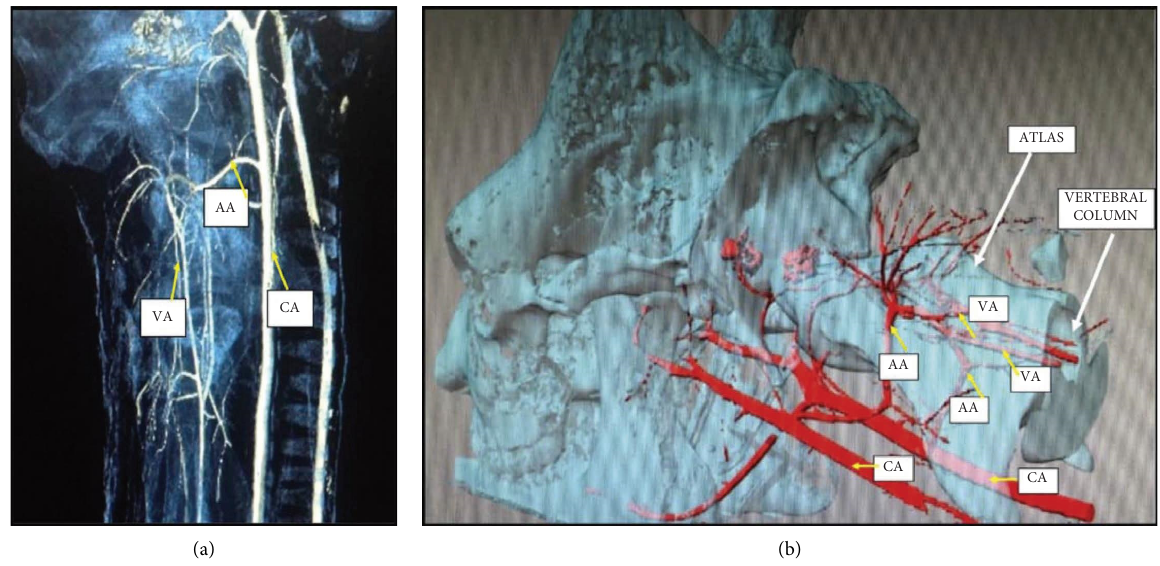
Figure 3: (a) Computerised tomography image illustrating the common carotid artery (CA), anastomotic artery (AA), and the vertebral artery (VA). (b) An illustration of the common carotid artery (CA), anastomotic artery (AA), and vertebral artery and the course of the vertebral arteries within the vertebral column through the atlas where they connect to the anastomotic artery.